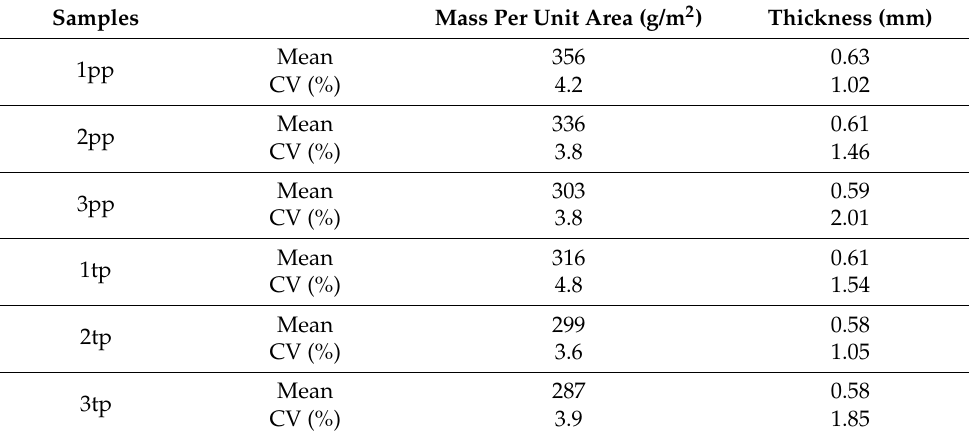
Table 5. Results of mass per unit area and